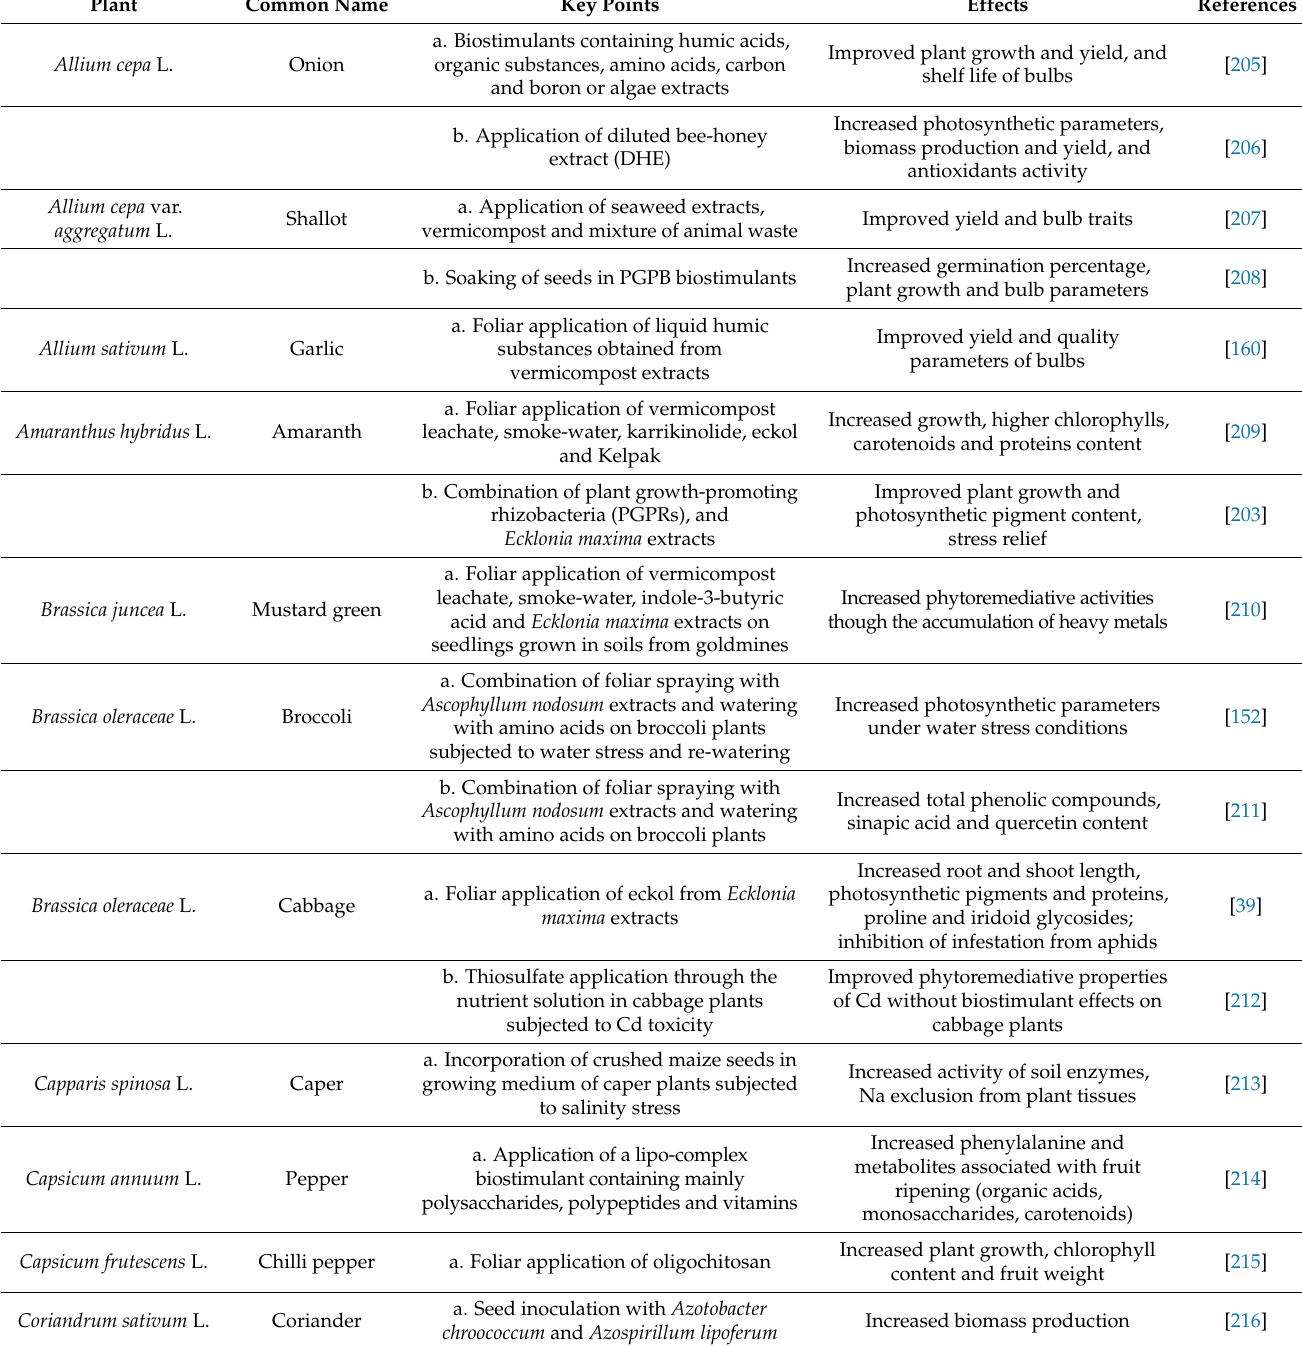
Table 2. Selected biostimulants effects on various vegetable